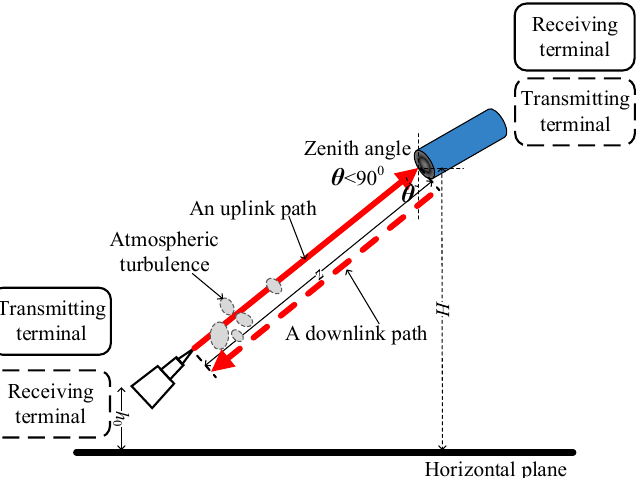
Figure 1. Diagram of laser beam propagation at an uplink or downlink transmission path.